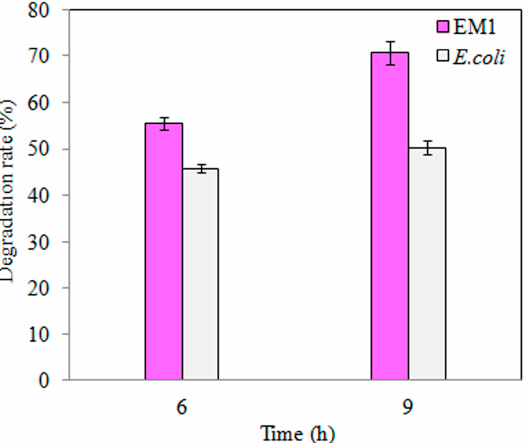
Figure 3. TNT degradation by wild-type E. coli (pink) and the S-M1 (grey) mutant strain. TNT degradation was followed for 6 h or 9 h, respectively. Data are presented as mean of N = 4, x ± SD. Statistical significance is denoted as p < 0.05 using SPSS.